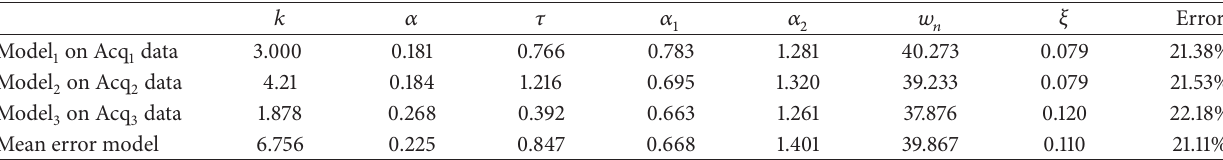
Table 1: FOTF parameters GAs optimized.